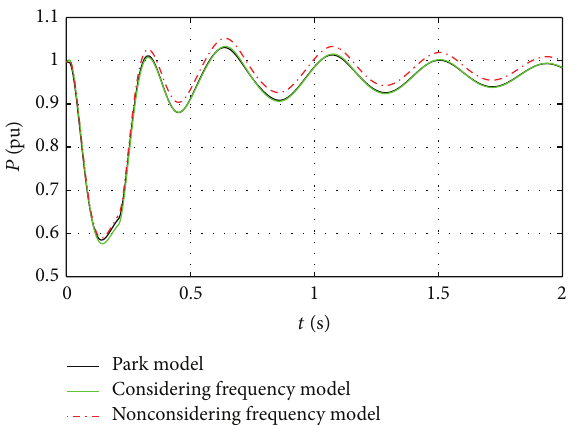
Figure 12: Active power of induction motor.